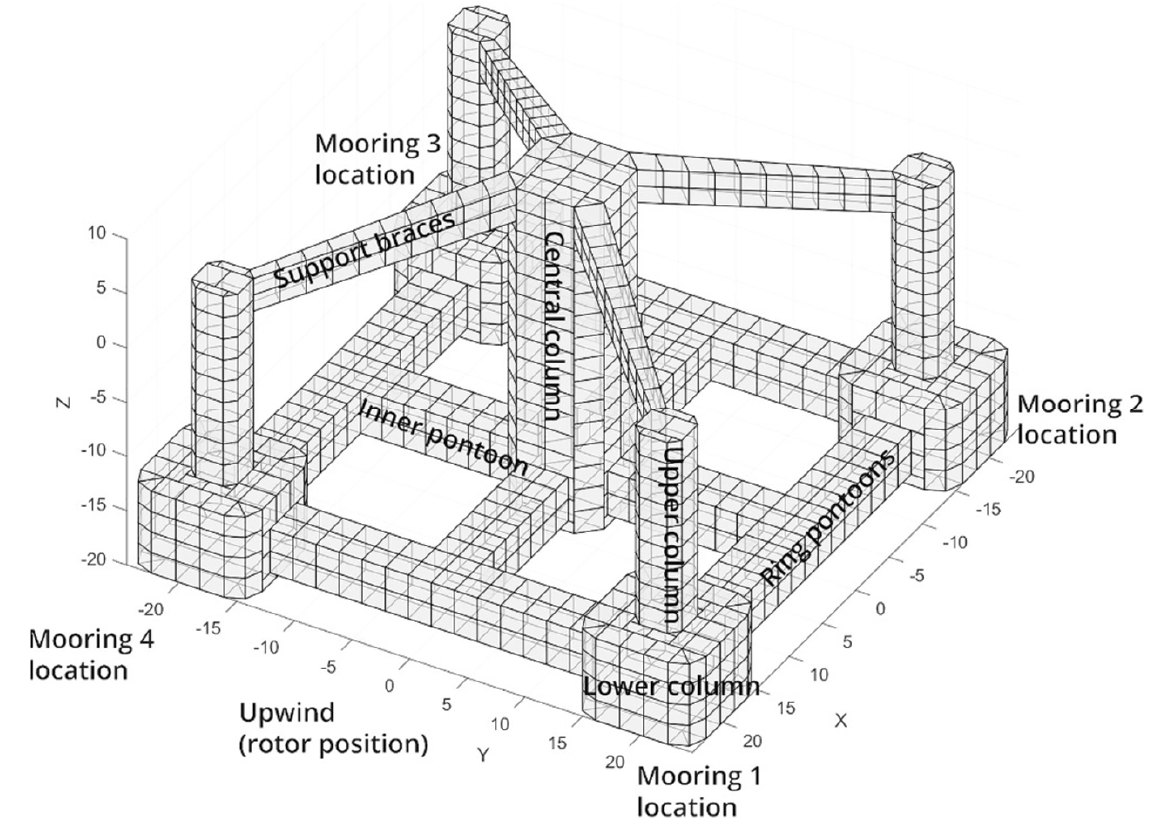
Figure 1. Hull form of CENTEC—TLP.